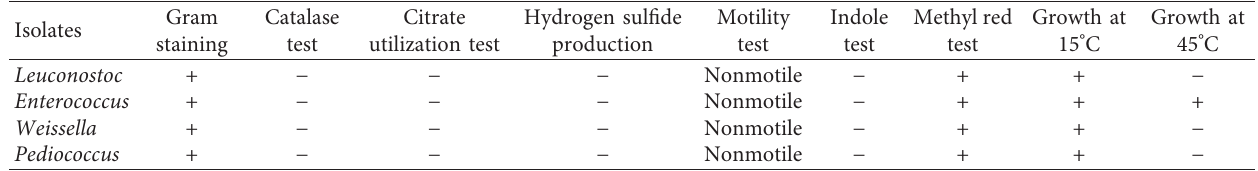
Table 3: Summary of different micromorphological/biochemical tests of isolates.